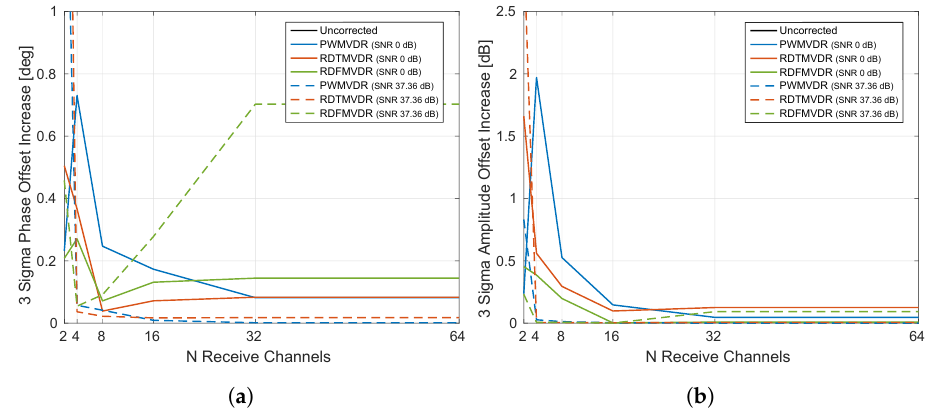
Figure 25. The 3 sigma error increase of the residual error image of scenario A at a RFI-Noise-Ratio of 40 dB vs. the antenna array length. The plots are shown for SNR = 0 dB (solid lines) and SNR = 37.36 dB (dashed lines). ( a ) Phase offset, ( b ) Gain